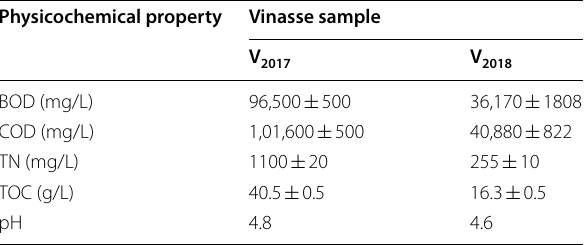
BOD biological oxygen demand; COD chemical oxygen demand; TN total nitrogen; TOC total organic carbon